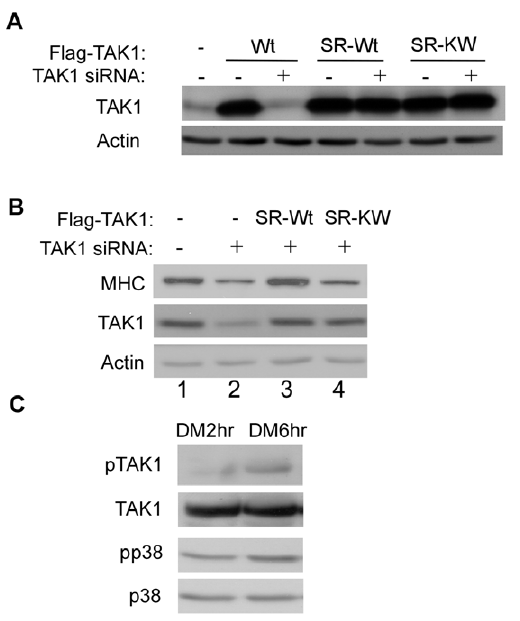
Figure 4. The kinase activity of TAK1 was required for myogenic differentiation. (A, B) C2C12 cells were co-transfected with a control siRNA or TAK1-siRNA together with various expression vectors as indicated. Wt: Flag-TAK1; SR-Wt: an siRNA-resistant wild-type TAK1; SR-KW: an siRNA-resistant kinase-dead TAK1. Cells were harvested at DM 36 h. The minus sign means that a control siRNA or an empty vector was used. (C) C2C12 cells were induced to differentiate in DM for 2 to 6 hours. WCE from (A–C) were prepared and subjected to SDS- PAGE and Western blot analysis for various proteins as indicated.